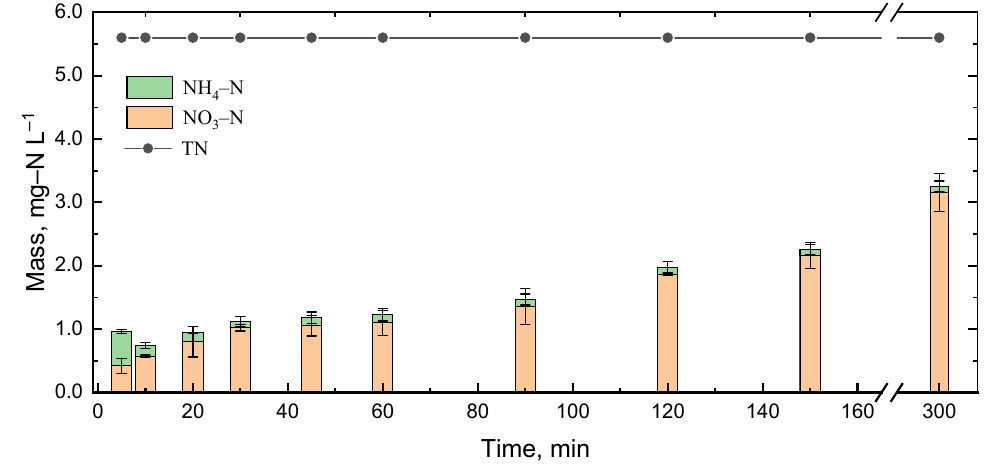
Figure 7. N-mass balance of TNT degradation process. Experimental conditions: (TNT) 0 = 30 mg/L, (Fe 2+ ) = 5 × 10 − 4 M, (H 2 O 2 ) = 5 × 10 − 3 M, (NaCl) = 10 − 2 M, Initial pH = 3.0 ± 0.1, US intensity = 8571 W/m 3 , Reaction time = 300 min.